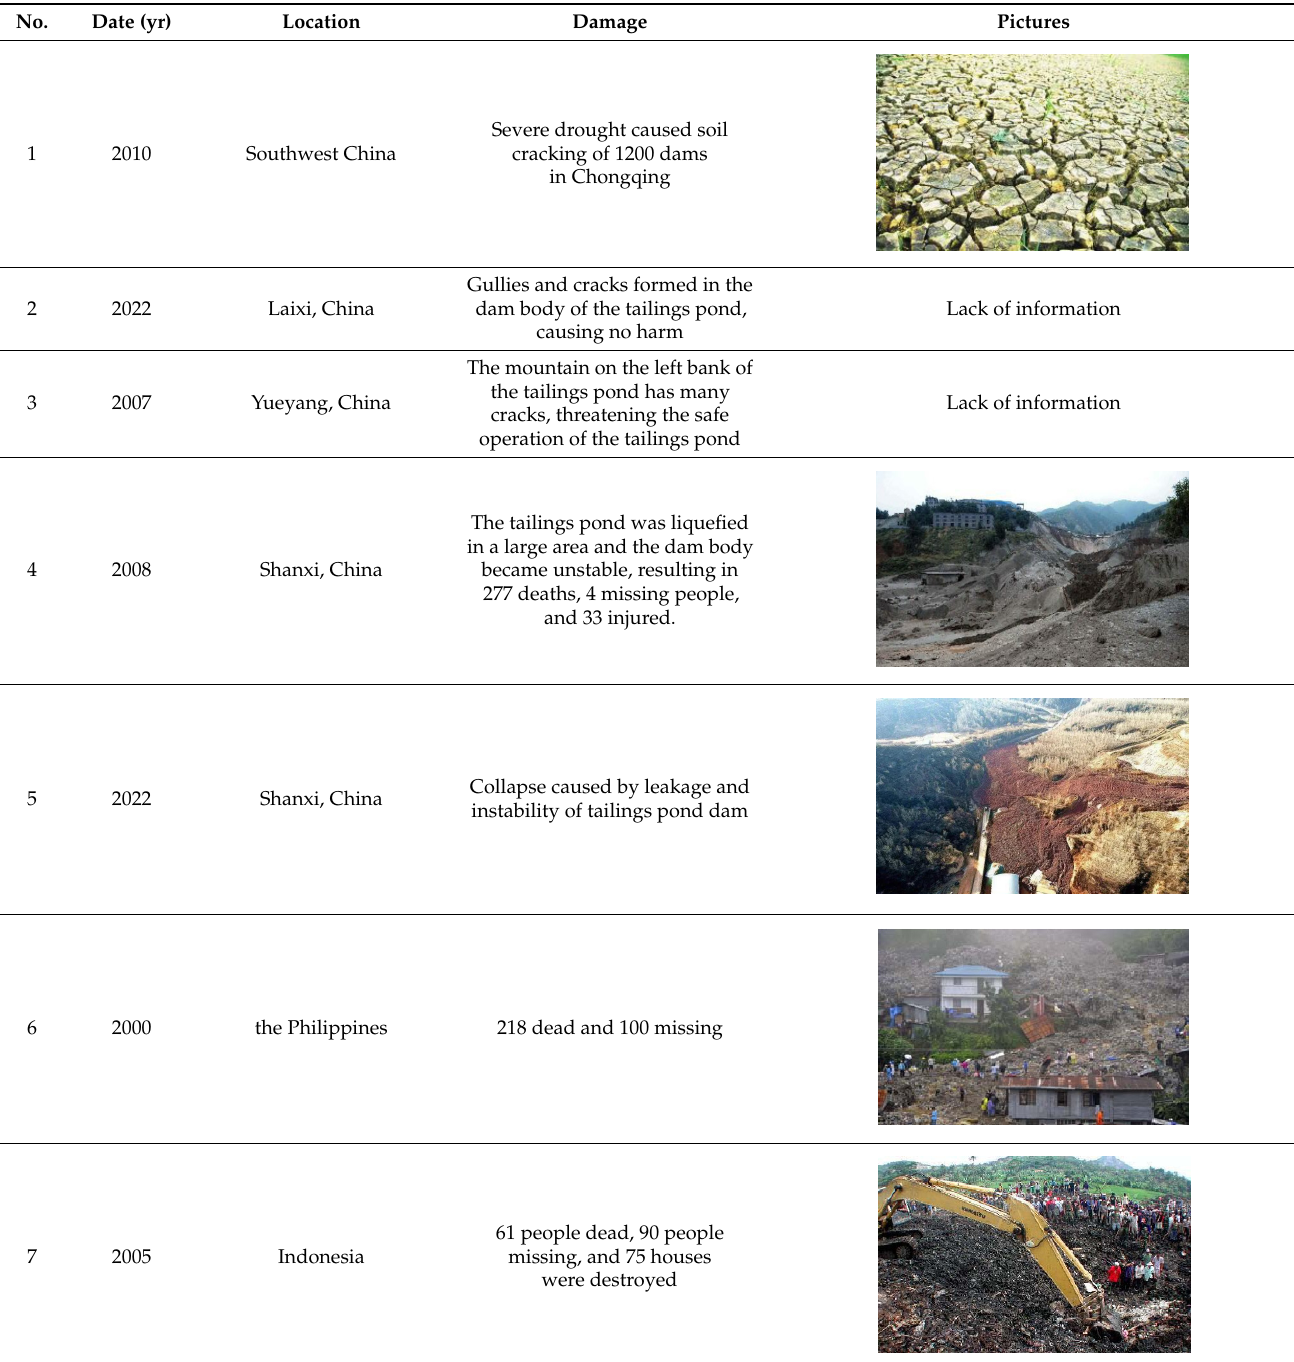
Table 1. Environmental disasters caused by soil cracking or instability.